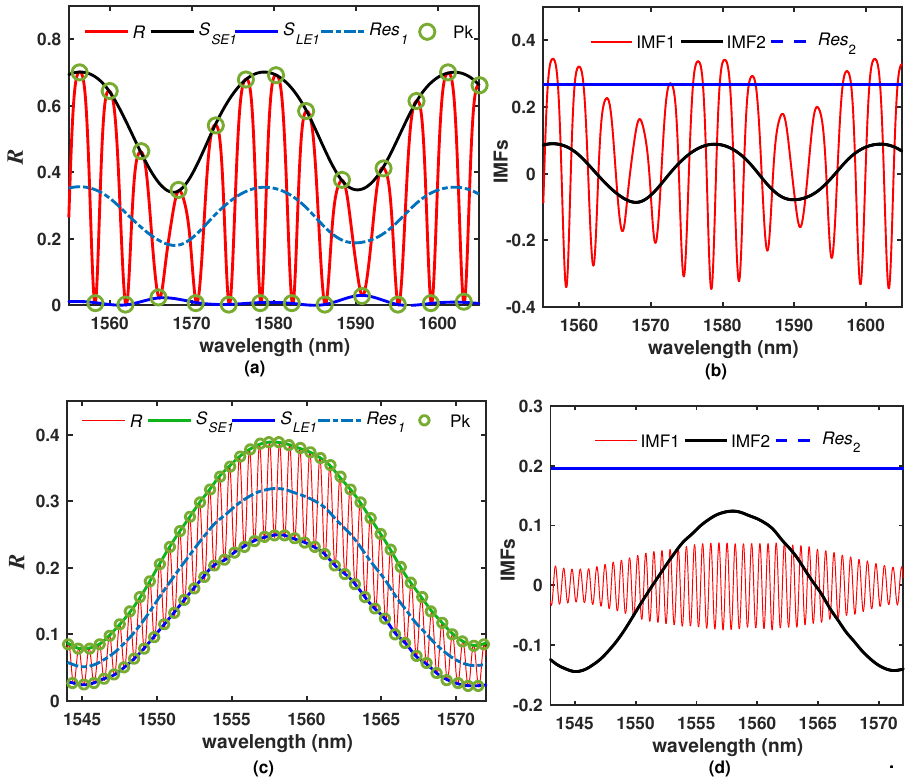
Figure 6. ( a ) Simulated ( R ) pattern of the filter F1 and the calculated signals required for decomposing this spectrum by using the EMD algorithm and ( b ) obtained IMFs and residual function; ( c ) Example of the experimental R pattern of the filter F2 and its corresponding ( d ) IMFs and residual